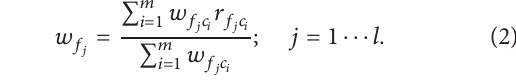
Algorithm 1 (multidimensional feature subset selection (MFSS)).